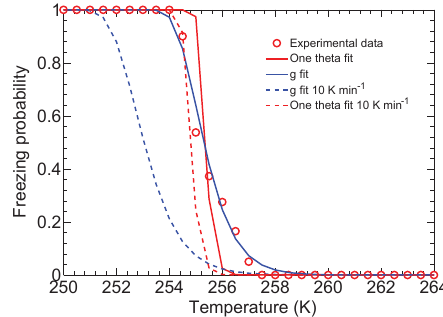
Figure 1. Experimentally determined freezing probabilities and fits from freezing of a droplet containing a single large ∼ 300µm diam- eter volcanic ash particle, from Fornea et al. (2009). Red dots are experimental freezing probabilities retrieved from repeated droplet freezing measurements. The red line is a fit to the data using clas- sical nucleation theory and the assumption of a single contact angle ( θ ). The blue line is a fit to the data using the g framework devel- oped here, which describes a Gaussian distribution of θ . The g fit has a least square error sum of 0.0197, µ = 1 . 65 and σ = 0 . 135. The dotted red line is the simulated freezing curve resulting from a single θ distribution for a simulated cooling rate of 10Kmin − 1 . The dotted blue line is the freezing curve from a multiple θ distribution described by g after the same simulated cooling